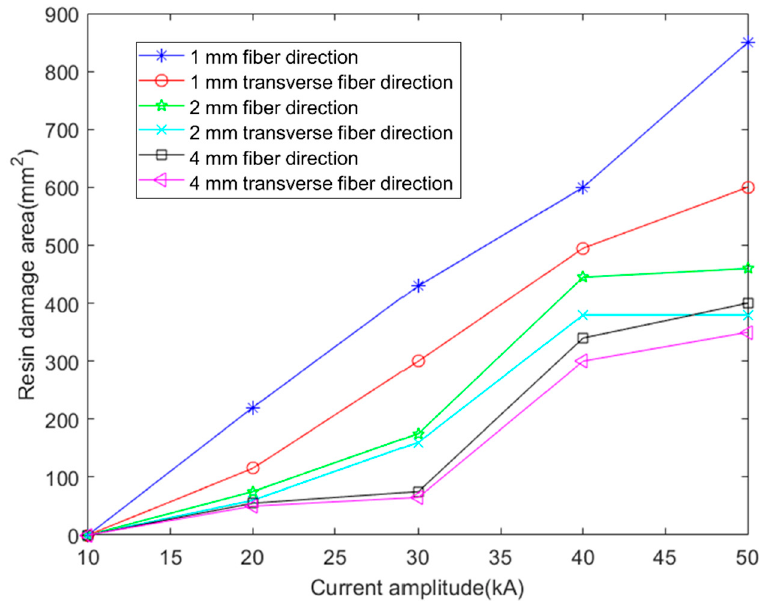
Figure 12. Influence of laminate thickness, discharge direction and lightning current amplitude on the creeping ablation damage area.